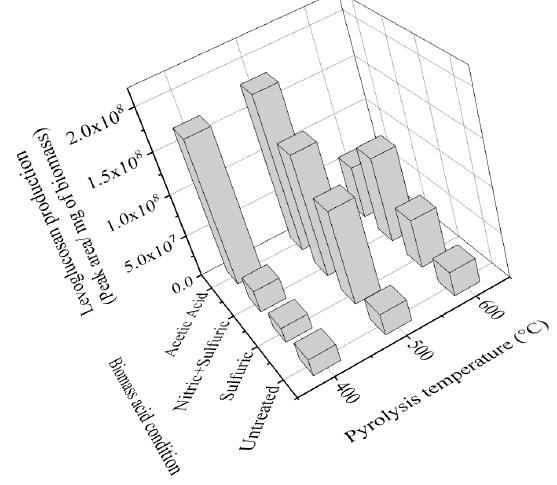
Figure 8. Production of levoglucosan from untreated and treated coffee husks with acetic acid (10 wt%); HNO 3 (0.1 wt%)/H 2 SO 4 (0.1 wt%); H 2 SO 4 (0.1 wt%) at 400, 500, and 600 °C.